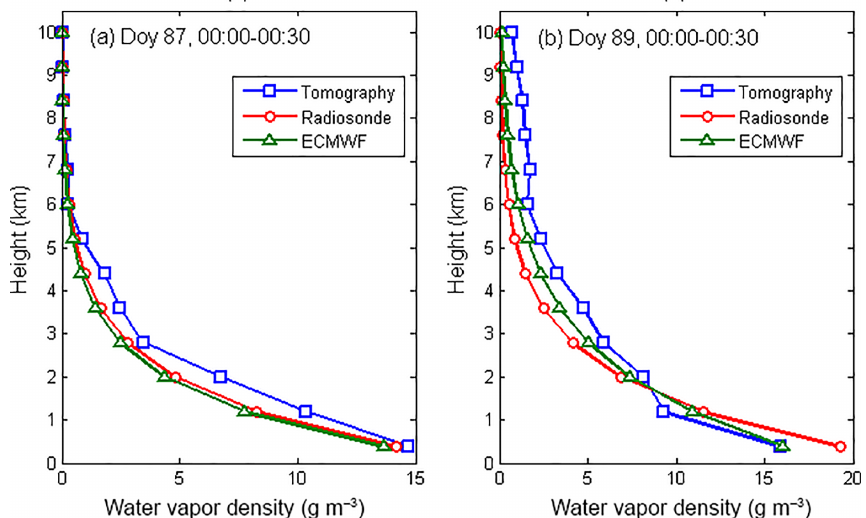
Figure 6. Water vapor density profile derived from radiosonde, ECMWF, and troposphere tomographic results. Time periods in panels (a) and (b) are 00:00–00:30UTC on DoY 87 and 89 in 2014, respectively.